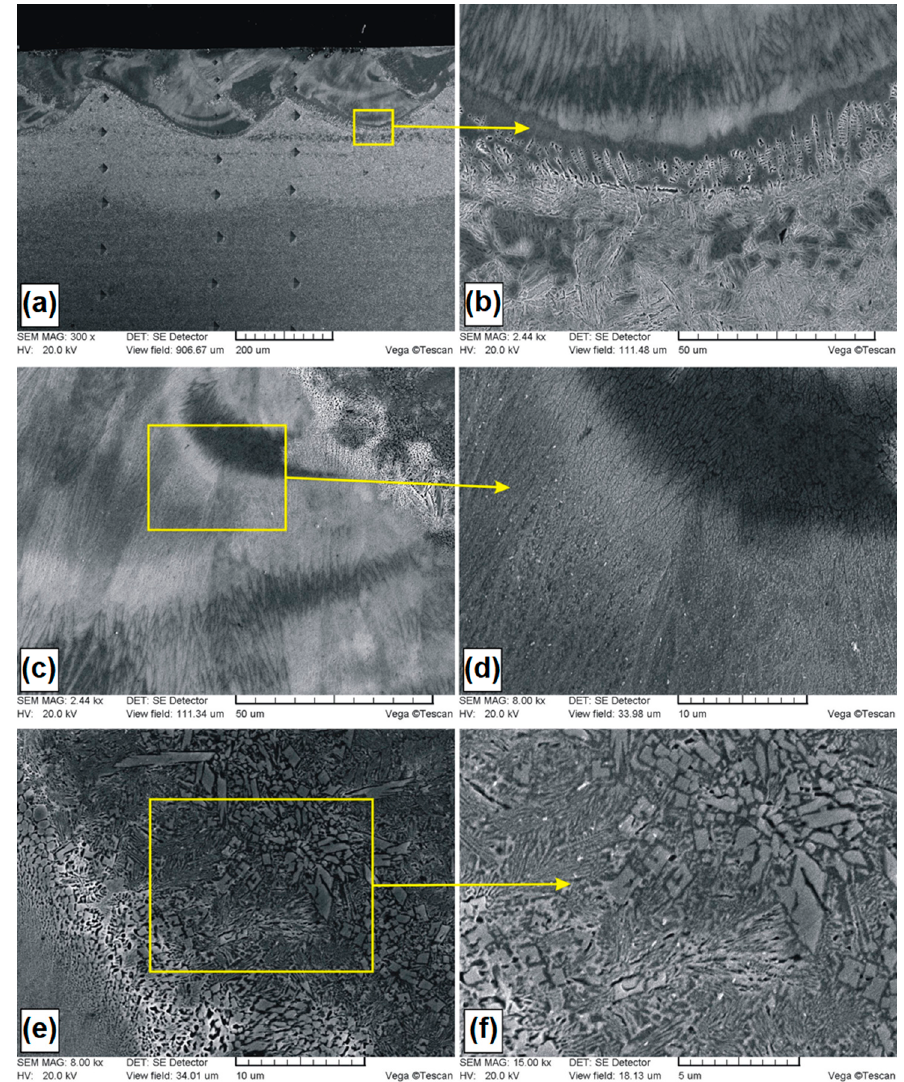
Figure 6. Microstructure of B-Si coating containing 20% boron and 80% silicon in pre-coat: ( a ) general view of laser tracks; ( b ) boundary between the MZ and HAZ; ( c ) central are area of the MZ; ( d ) magnification of central area; ( e ) crystals in the MZ; ( f ) magnification of crystals.